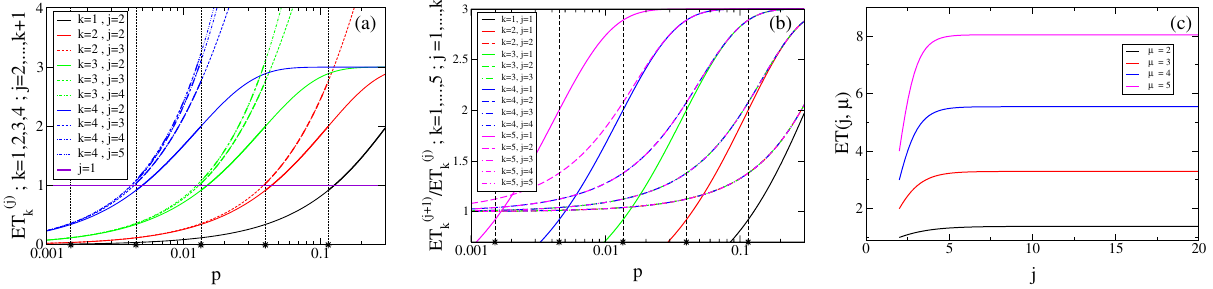
( j ) ( m , p ) , at each stage, j , with k 1 (black), k 2 (red), k 3 ( 3 k , . . . , 3 ) with k = = = = 1 ) 1 ) ( j = ( m , p )/ ET ( j ) ( m , p ) , of the + k k 1 (black), k 2 (red), k 3 (green), k 4 (blue) and k 5 (magenta). = = = = = 2 (black), µ 3 (red), µ 4 (blue) and µ 5 = = = =